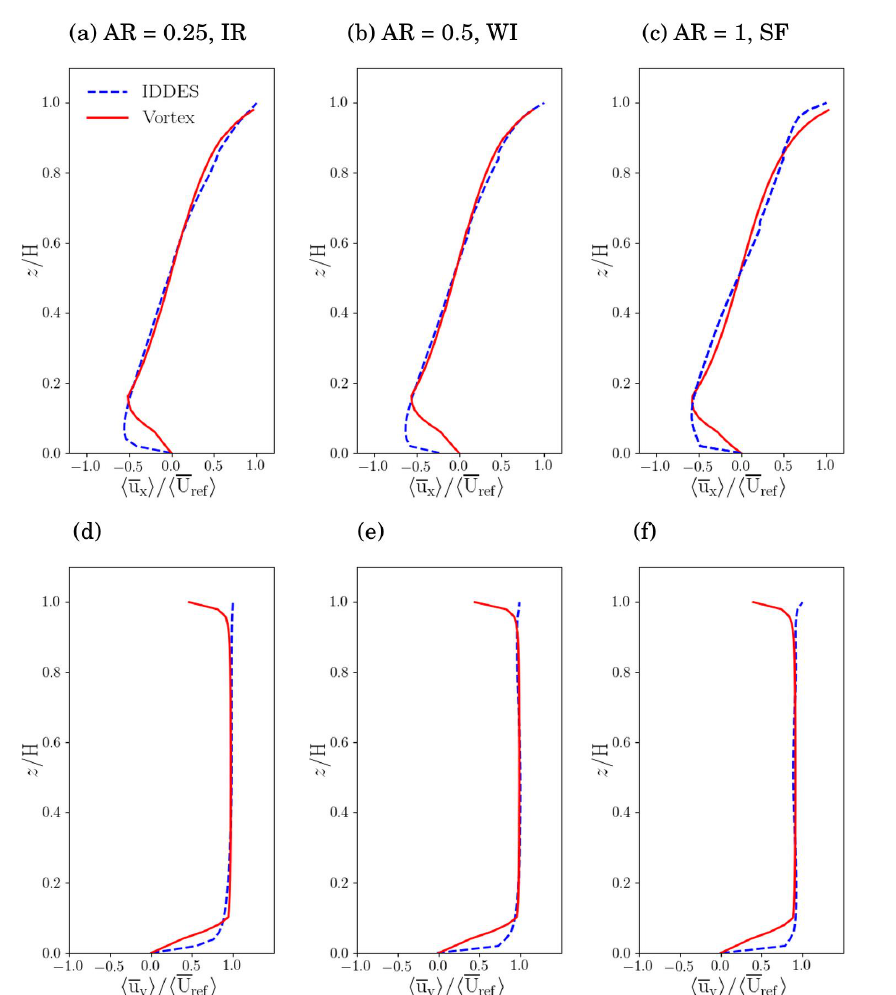
Figure 5. Vertical profiles of normalised velocities for AR and IDDES (dashed lines) profiles are compared for: ( a , d ) AR = 0.25; ( b , e ) AR = 0.5; ( c , f ) AR = 1. Streamwise ( top ) and spanwise ( bottom ) velocities are normalised by velocity at z / H =1. Henceforth this definition of